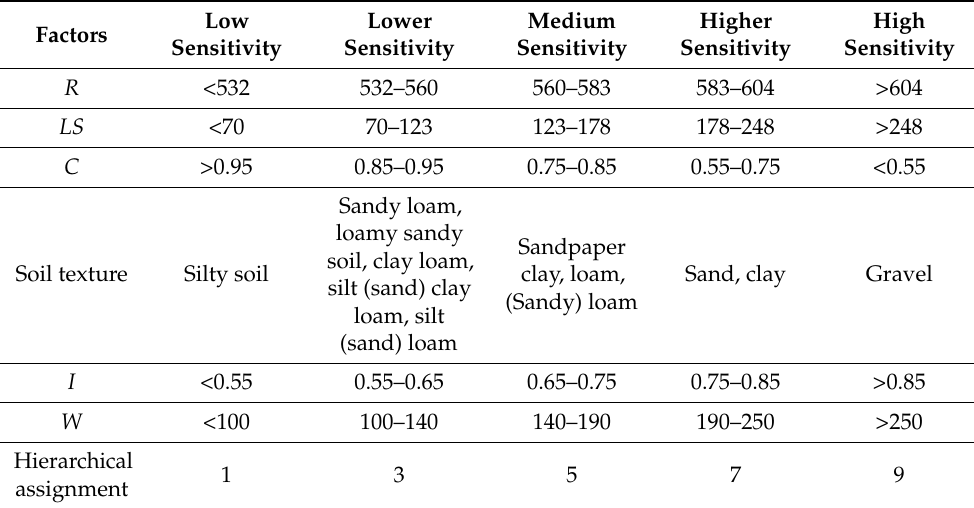
Table 1. Classification and assignment of eco-environmental assessment factors in the Minjiang River